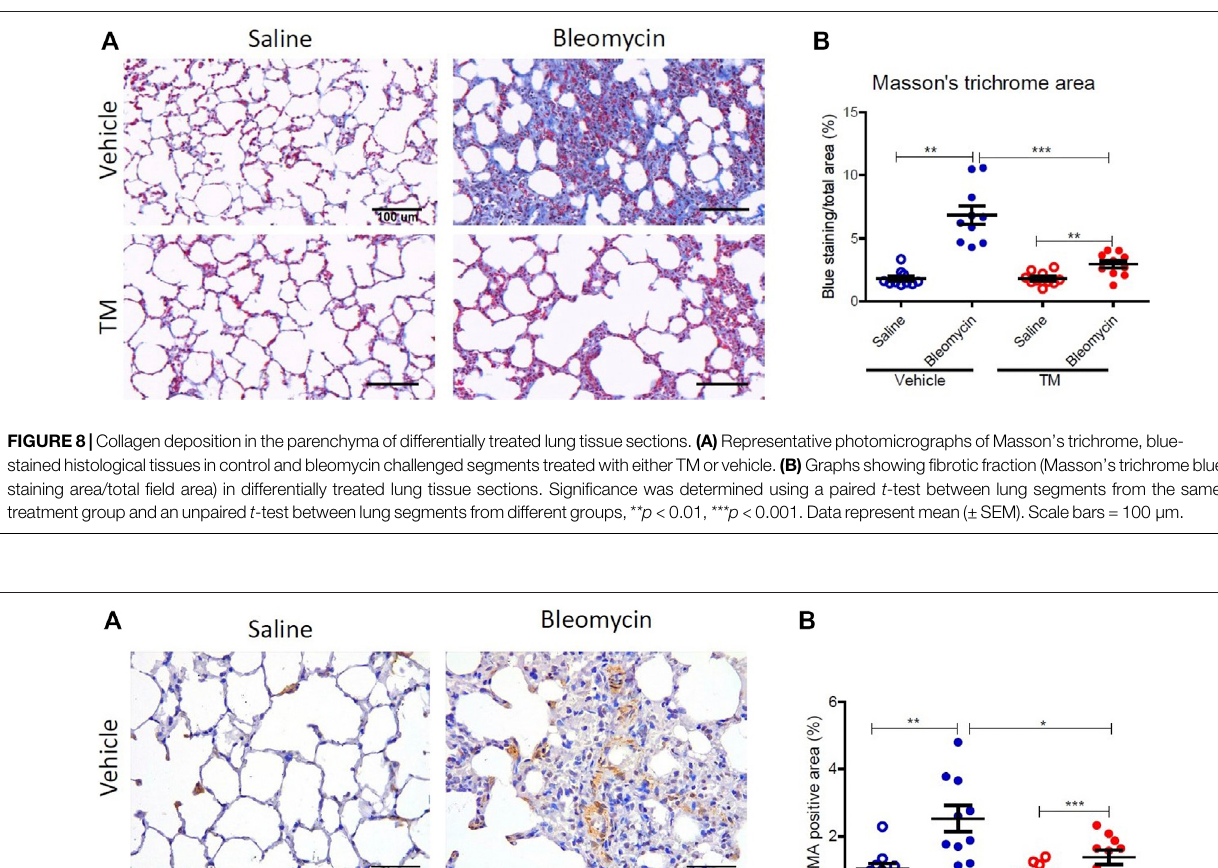
Frontiers in Pharmacology |